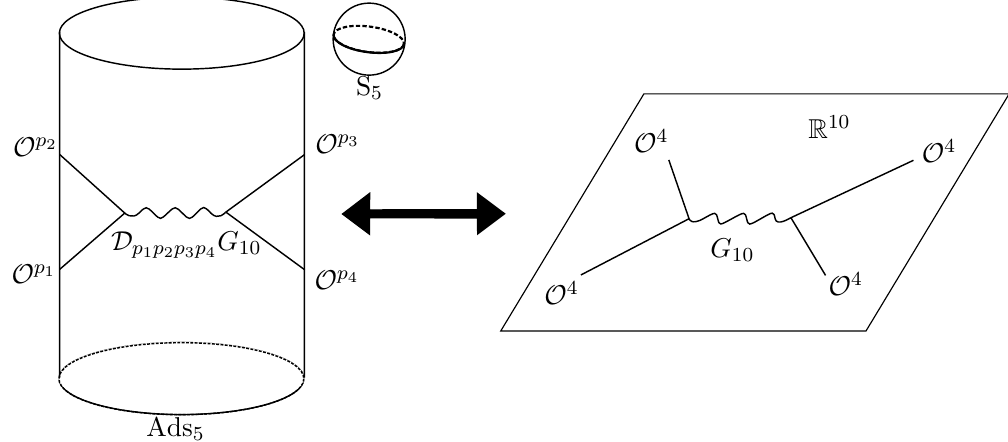
Figure 4 . The (cid:13)at-space limit of a scattering process in AdS 5 (cid:2) S 5 map to one in R 10 . In the (cid:13)at-space limit, the dilaton has (cid:1) = 4. We conjecture that the ten-dimensional dilaton correlator G 10 can be projected to a AdS 5 (cid:2) S 5 correlator by a suitable di(cid:11)erential operator D p on G 10